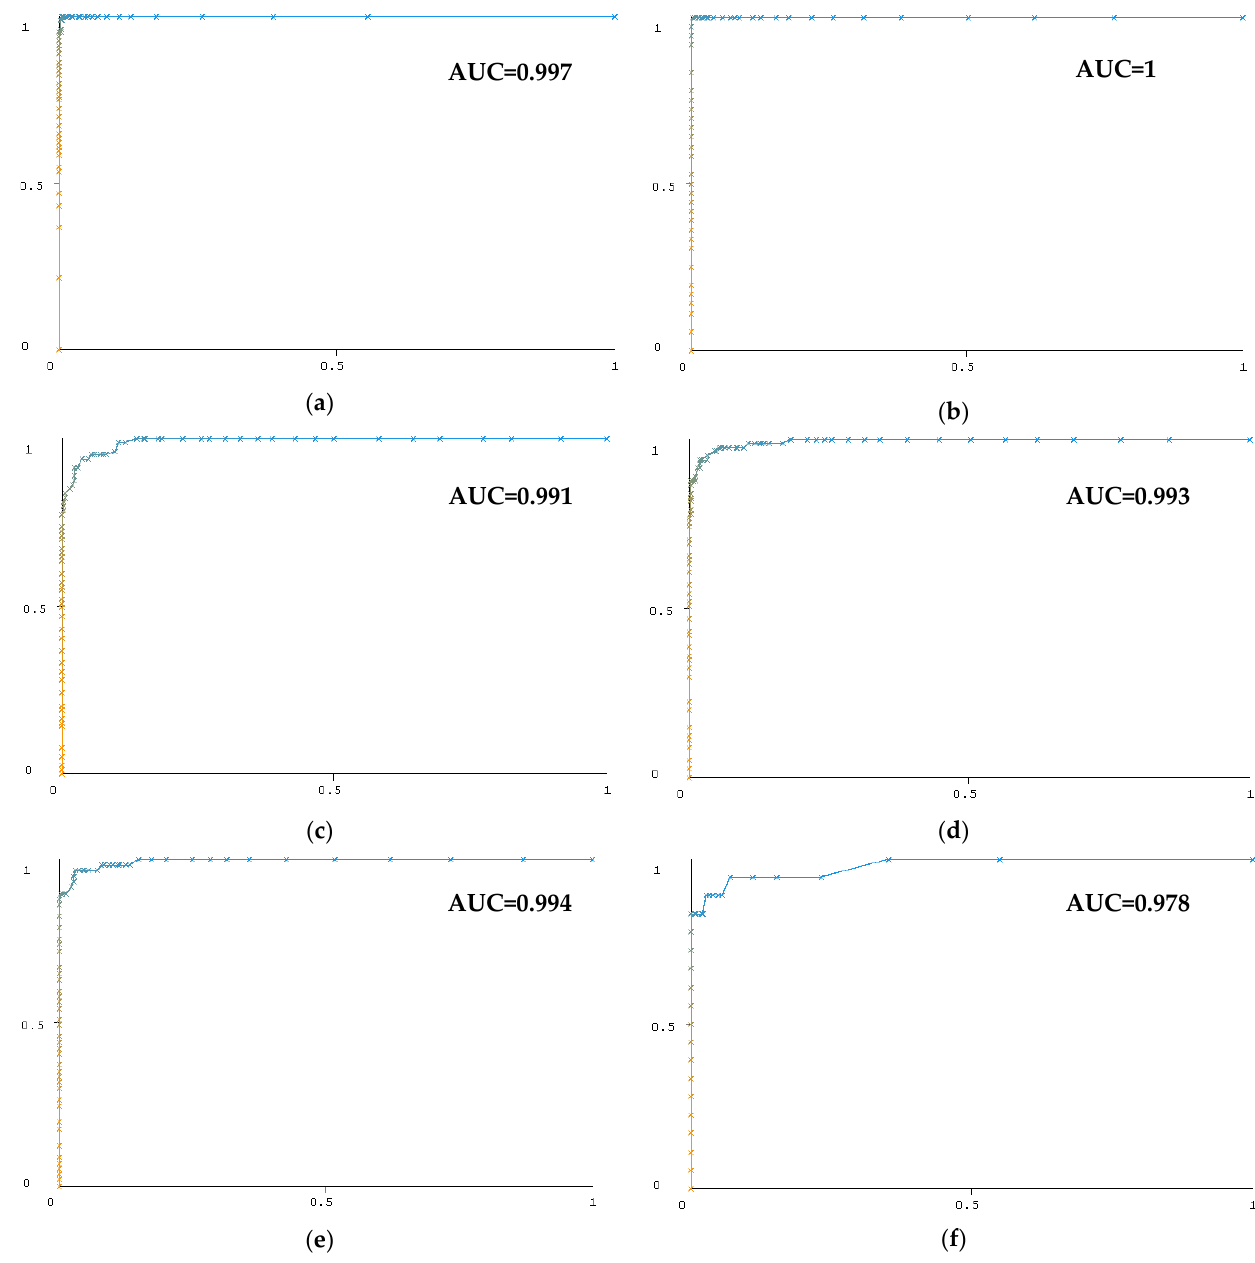
Figure 10. ROC curves for classi fi cation of unbalanced data with Random Forest. ( a ) GCS3 class, ( b ) GCS4 class, ( c ) GCS5 class, ( d ) GCS6 class, ( e ) GCS7 class, and ( f ) GCS8 class.